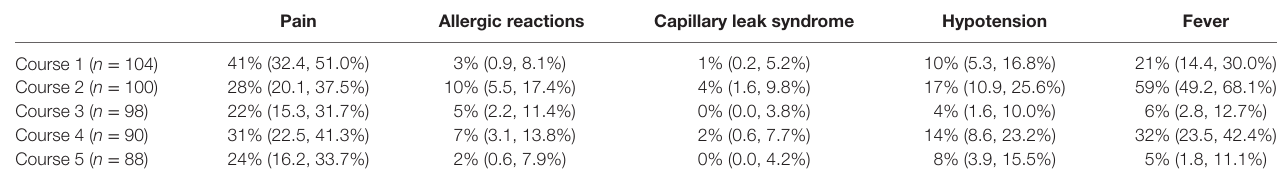
TaBlE 5 | Median duration (in days) of select adverse events within the subset of patients who experienced those events a .